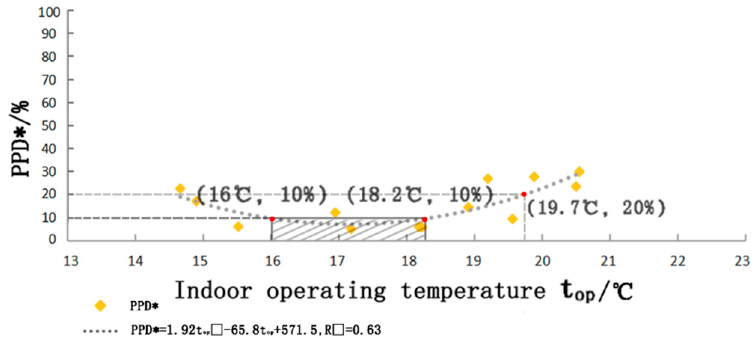
Figure 16. Indoor operating temperature graph (source: self-drawn).